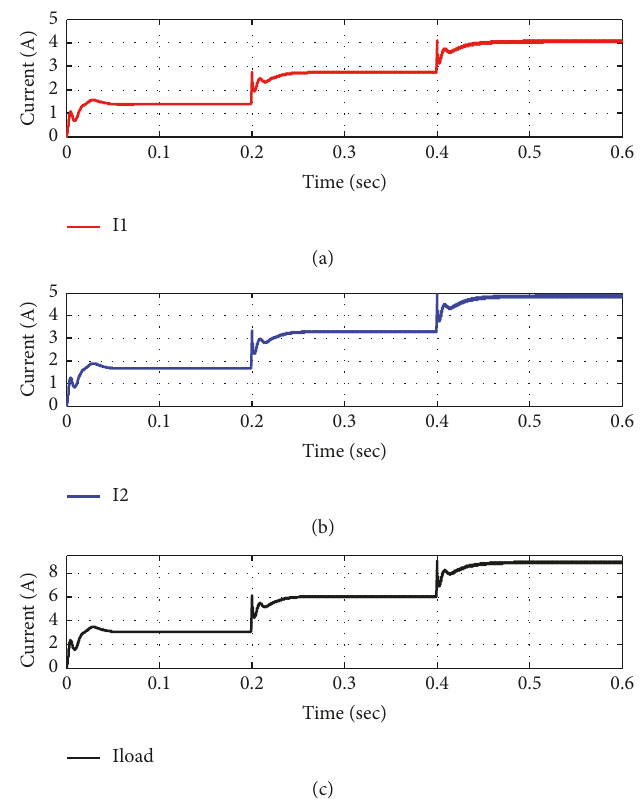
Figure 20: The output current from the simulation results for optimized control case. (a) Converter I output current; (b) converter II output current; (c) load